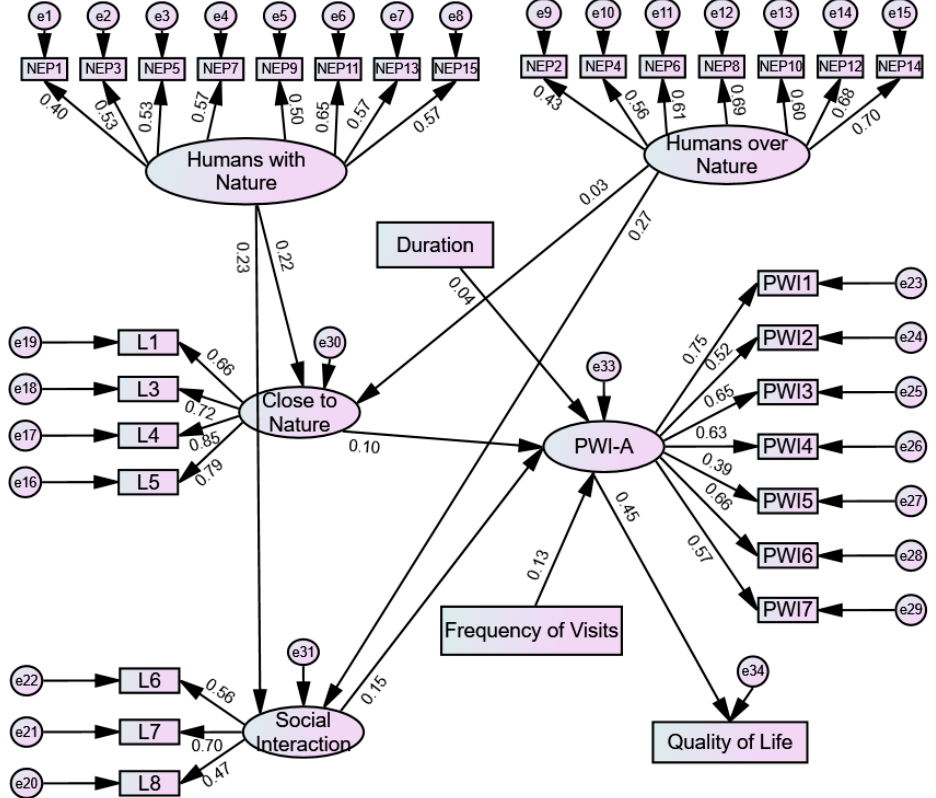
Figure 3. Structural equation model for the 2019 sample.